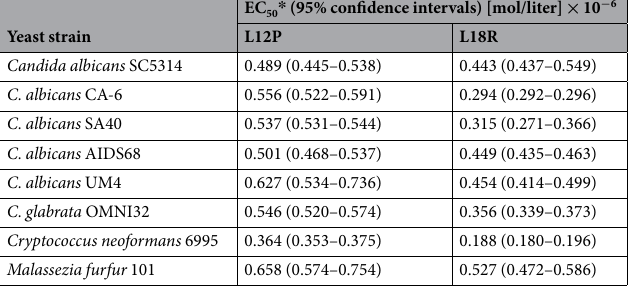
Table 2. In vitro fungicidal activity of the selected peptides L12P and L18R. * EC 50 , half maximal effective concentration, calculated by nonlinear regression analysis using Graph Pad Prism 4.01